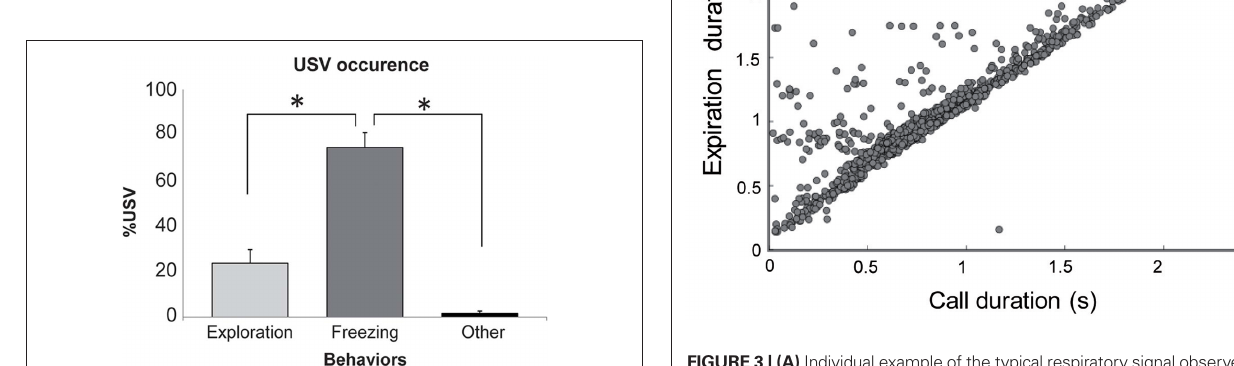
Figure 3 | (A) Individual example of the typical respiratory signal observed during ultrasonic vocalizations (USV). Upper part : frequency spectrogram of calls. Lower part : corresponding respiratory signal. For each USV, a short inspiration preceded call emission while a long expiration was concomitant with it. (B) The duration of USV was highly correlated with the duration of the expiration phase ( r 2 = 0.761; p